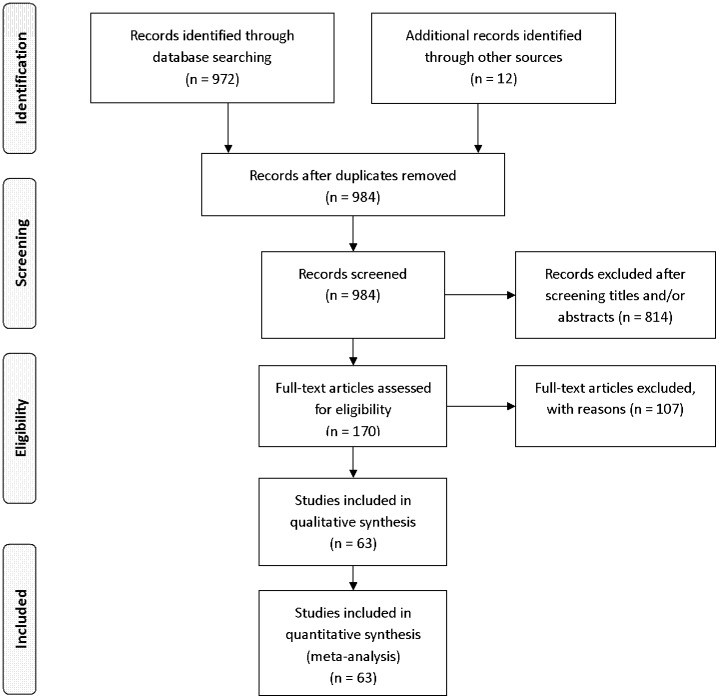
Selection of relevant publications, reasons for exclusion.